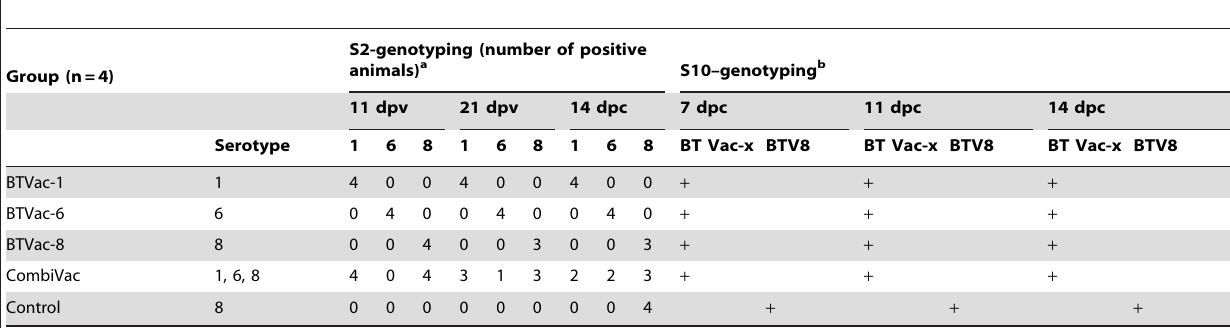
Table 2. Genotyping results from vaccinated and challenged animals with serotype specific PCR tests on Seg-2 (S2-genotyping) and restriction enzyme analysis of amplicons of the panBTV-PCR test (S10-genotyping).